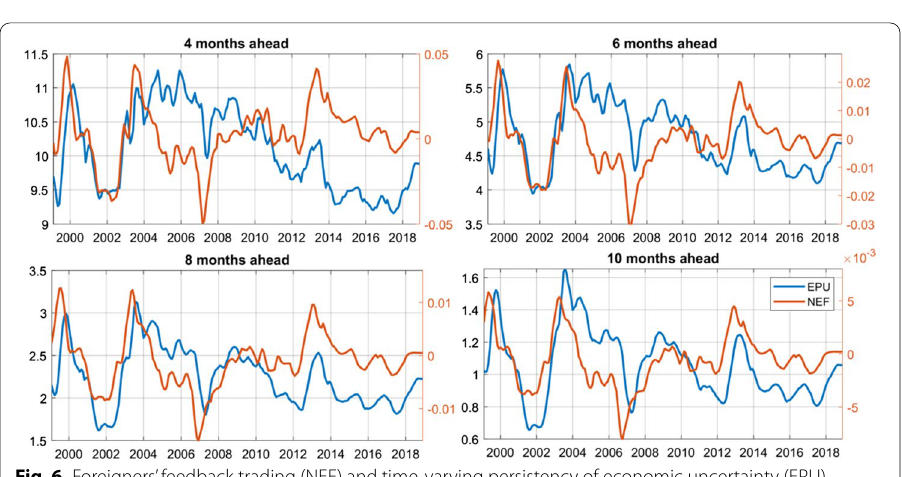
Fig. 6 Foreigners’ feedback trading (NEF) and time-varying persistency of economic uncertainty